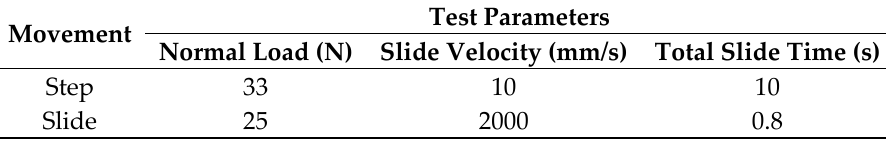
Table 1. Test parameters for steps and slides with the tests done by each tread